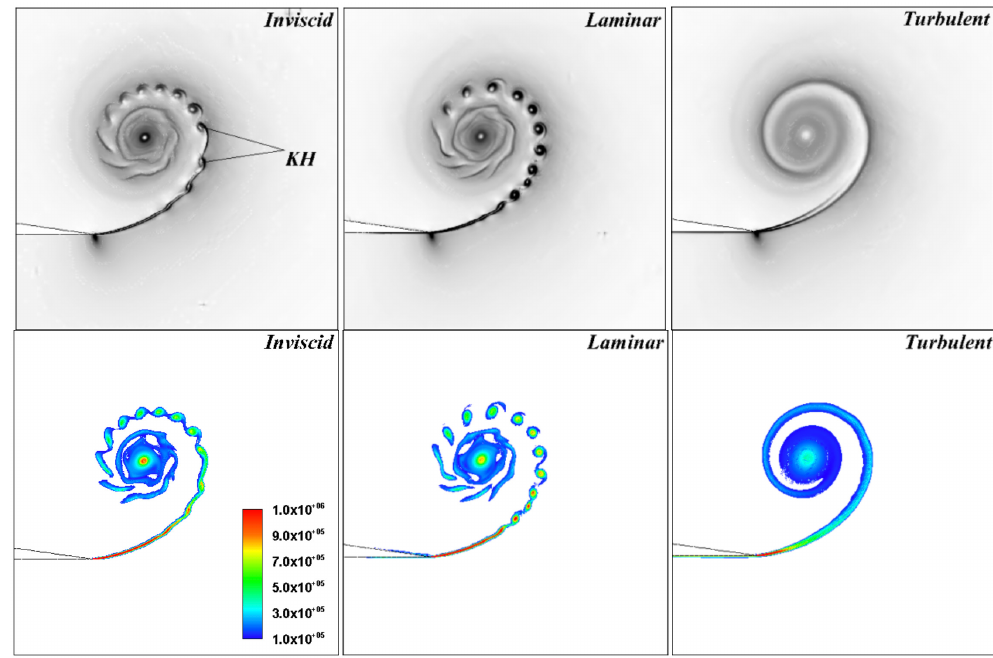
Fig. 6. Schlieren (left) and vorticity (right) of shock wave diffraction around sharp splitter for different solvers